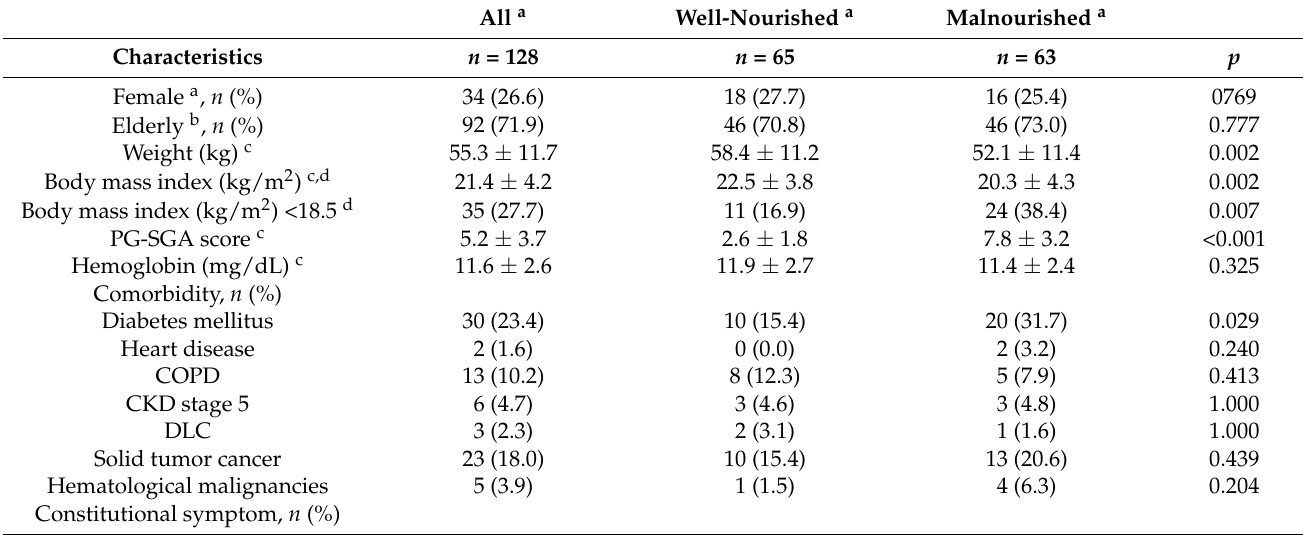
Table 1. Clinical characteristics and comparison analysis of well-nourished and malnourished patients with tuberculosis treated with regimens containing rifampicin, isoniazid, and